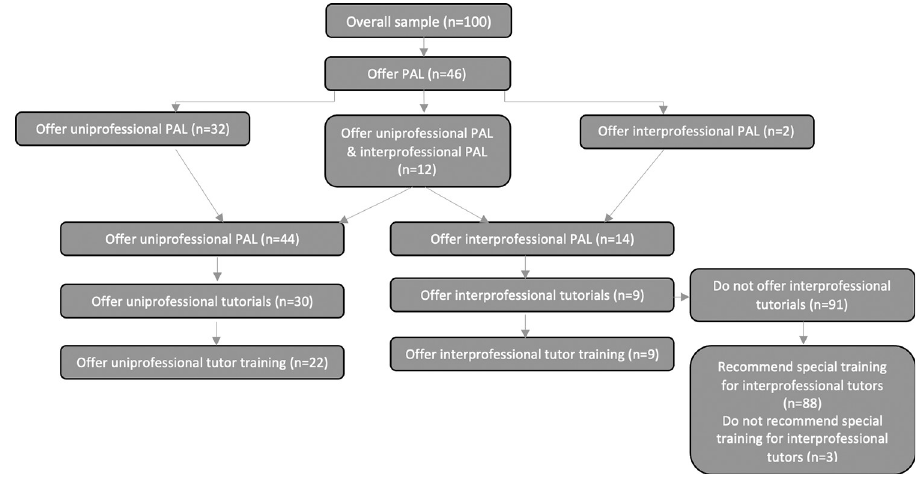
Fig 1. Overview of sub-samples.